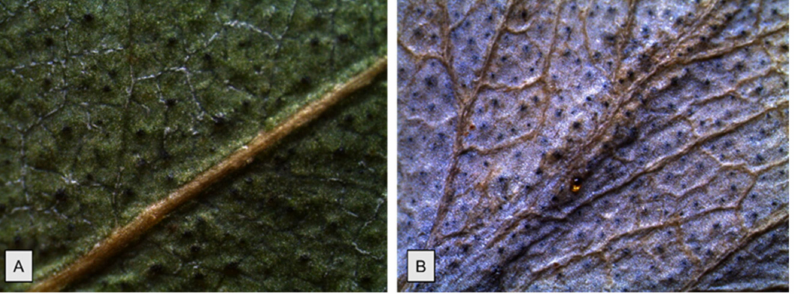
Figure 2. Abaxial surfaces of E. gunnii ( A ) and of E. pulverulenta ‘Baby blue’ ( B ) at 2.5 × magnification. The observation by both light microscopy (LM) and scanning electron microscopy (SEM) showed in both species the amphistomatal leaves with anomocytic stomata, oval or rounded, appearing at the same level as the neighbouring epidermal cells and as the overlying cells surrounding oil cavities (Figure 3A–H and Figure 4A–D). These